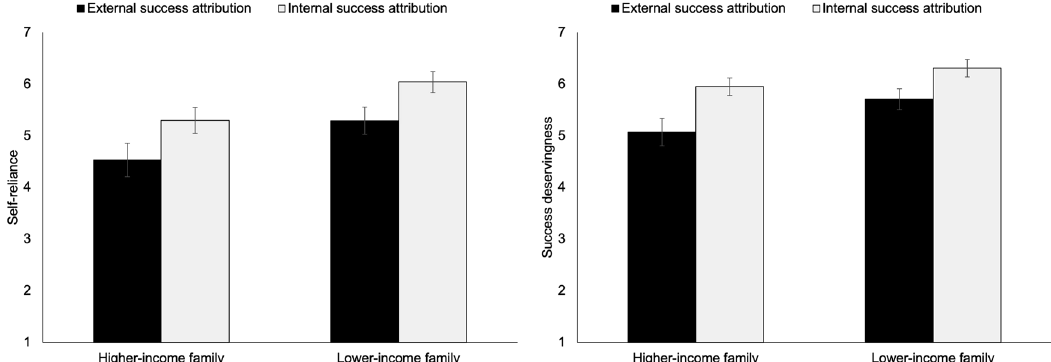
Fig. 1 Self-reliance and success deservingness. Mean ratings of self-reliance (left) and success deservingness (right) in Study 4. Note: Error bars indicate ±